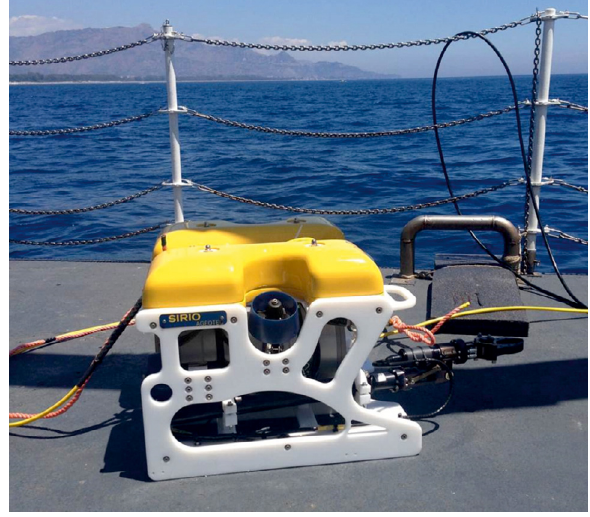
Figure 5. The Sirio ROV by Ageotec used during the cruise.